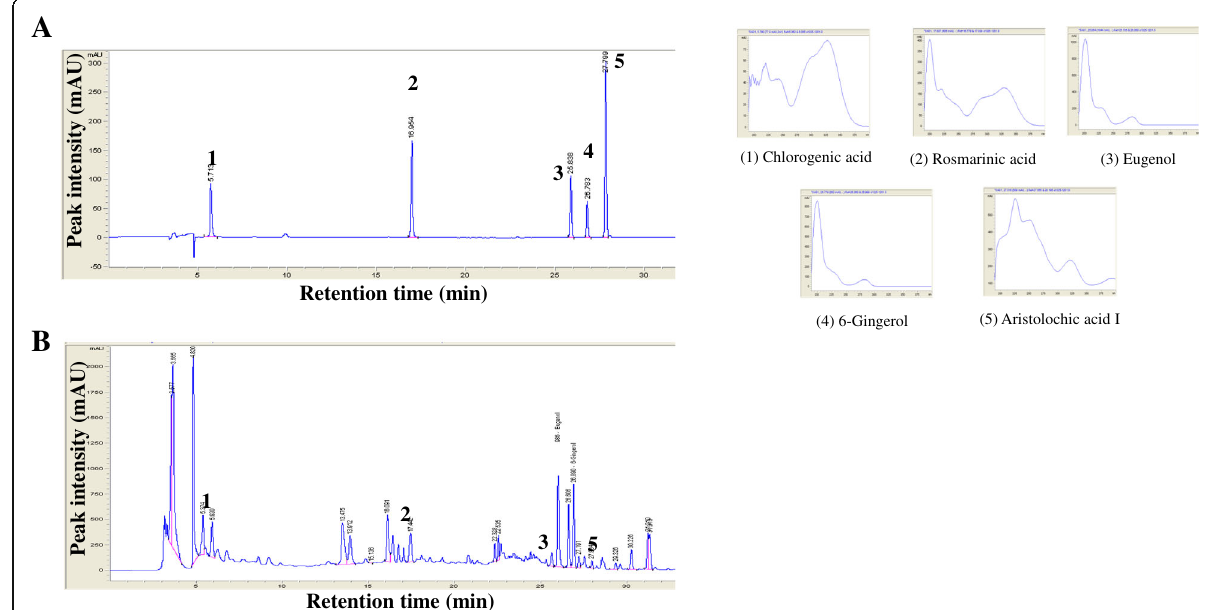
Fig. 1 Fingerprinting of eCS. a The representative chromatogram used as standard markers is shown: chlorogenic acid (1) of Xanthii Fructus, rosmarinic acid (2) of Menthae Herba, eugenol (3) of Syzygii Flos, 6-gingerol (4) of Zingiberis Rhizoma Crudus, and aristolochic acid I (5) of Asiasari Radix. The key marker compounds detected in the 50% ethanol extract of CS (eCS) are shown in ( b